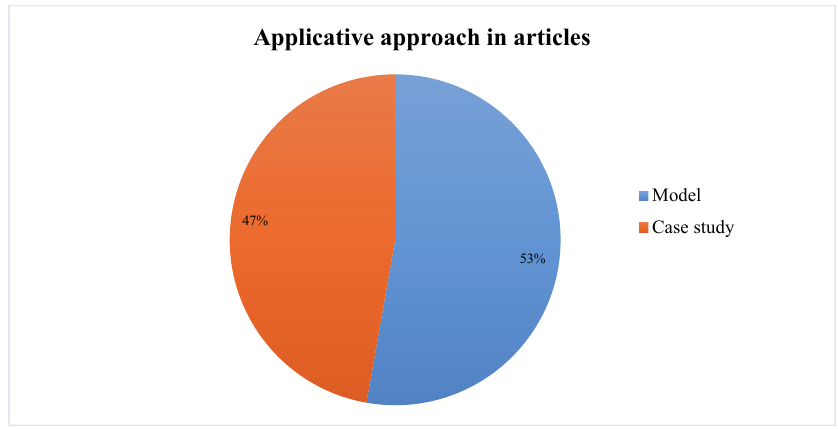
Fig. 4. Distribution of the type of